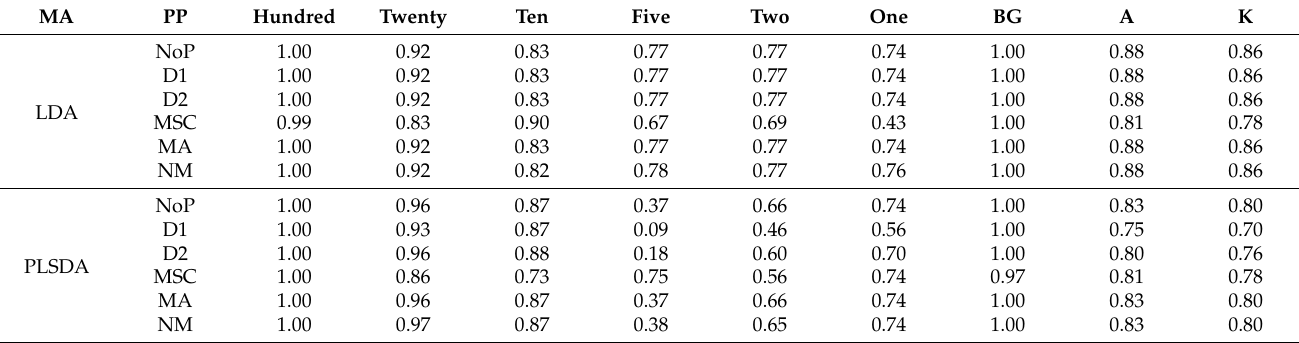
Table 3. Result of the classification of the diluted residues of spinach as the accuracy ( A ) and kappa coefficient ( K ) based on chemometric